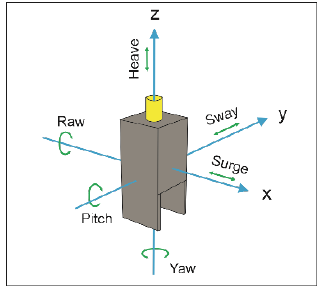
Figure 8. Definition sketch for six degrees of freedom (6-DOF).